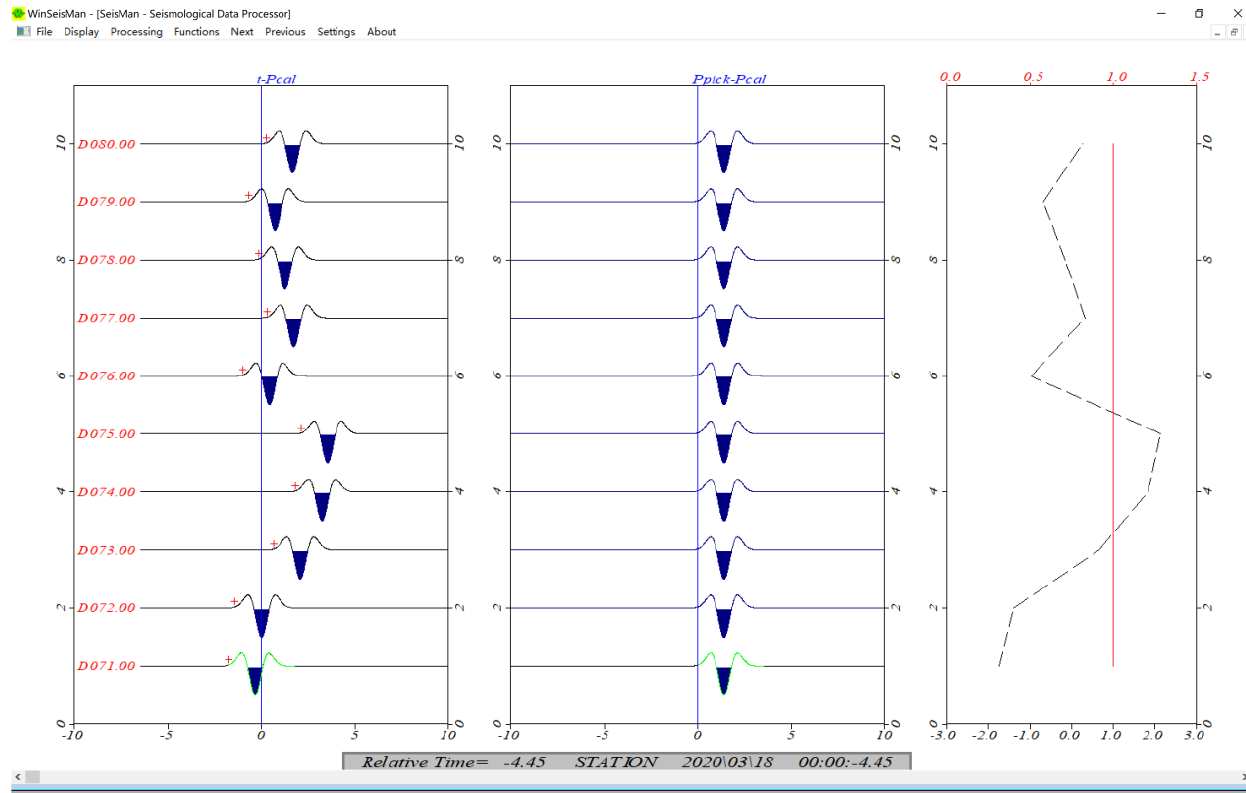
Figure 4. Cross-correlation evaluation system. The left and middle panels show the seismic wave- forms centered on the theoretical and measured traveltimes. The red line on the rightmost graph is the correlation coefficient, and the corresponding numbers are the upper red axis. The black line shows the residual difference between the measured traveltime and the theoretical traveltime; the corresponding numbers are the lower black coordinates in seconds.